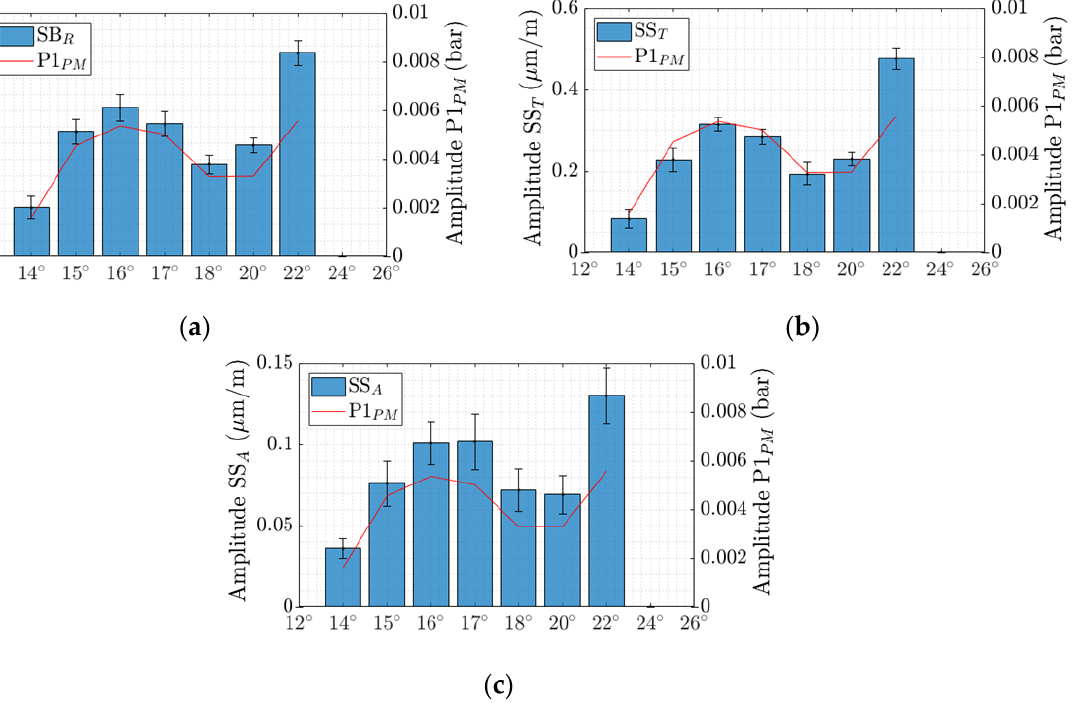
Figure 12. Runner blade strain levels at f rvr in sensor SB R ( a ) and shaft strain levels at f rvr due to torsional moments in position SS T ( b ) and due to axial forces in position SS A ( c ) at α from 12° to 26°.